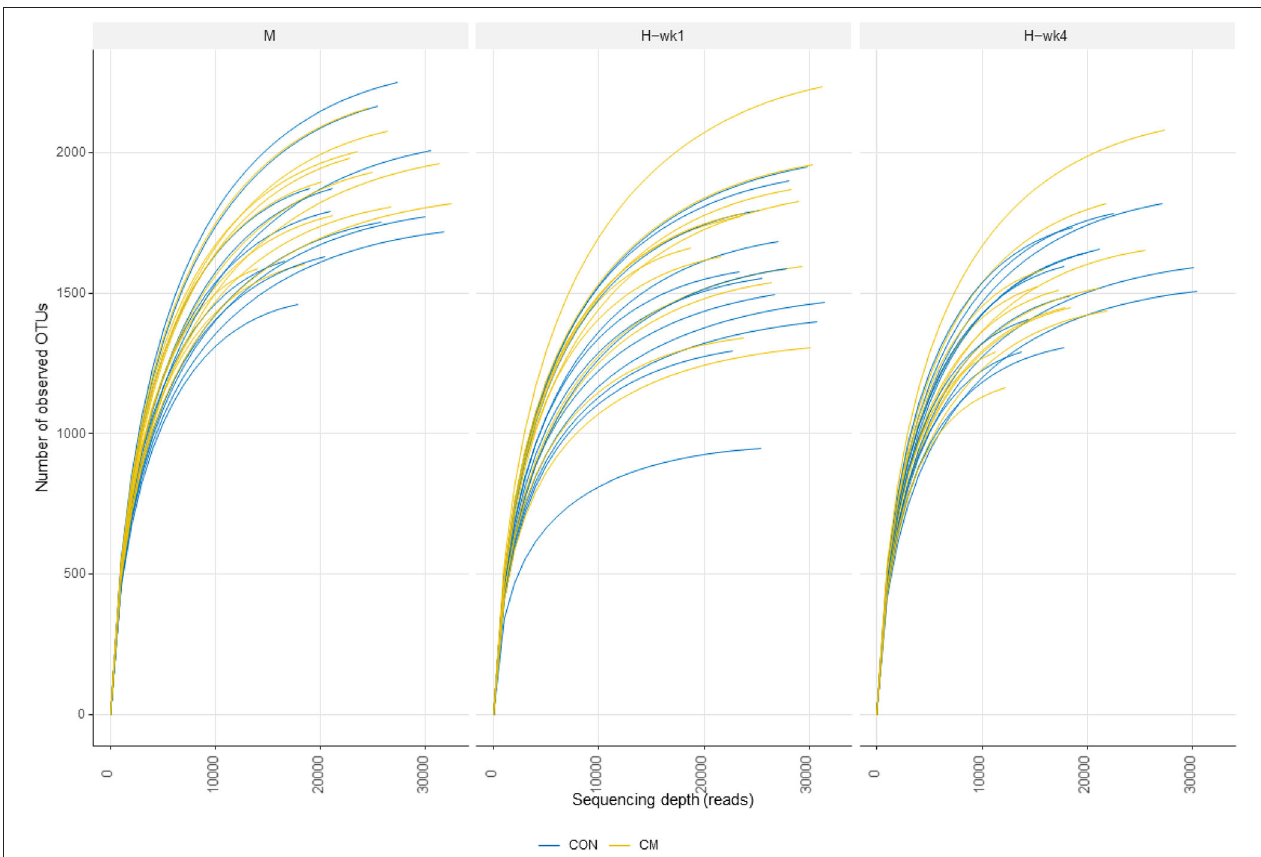
FIGURE 2 | Rarefaction curves indicating the number of operational taxonomic units (OTUs) during moderate-grain feeding (M), week 1 of high-grain feeding (H-wk1), and week 4 of high-grain feeding (H-wk4). Control (CON) and treatment (CM) samples are show in blue and yellow,